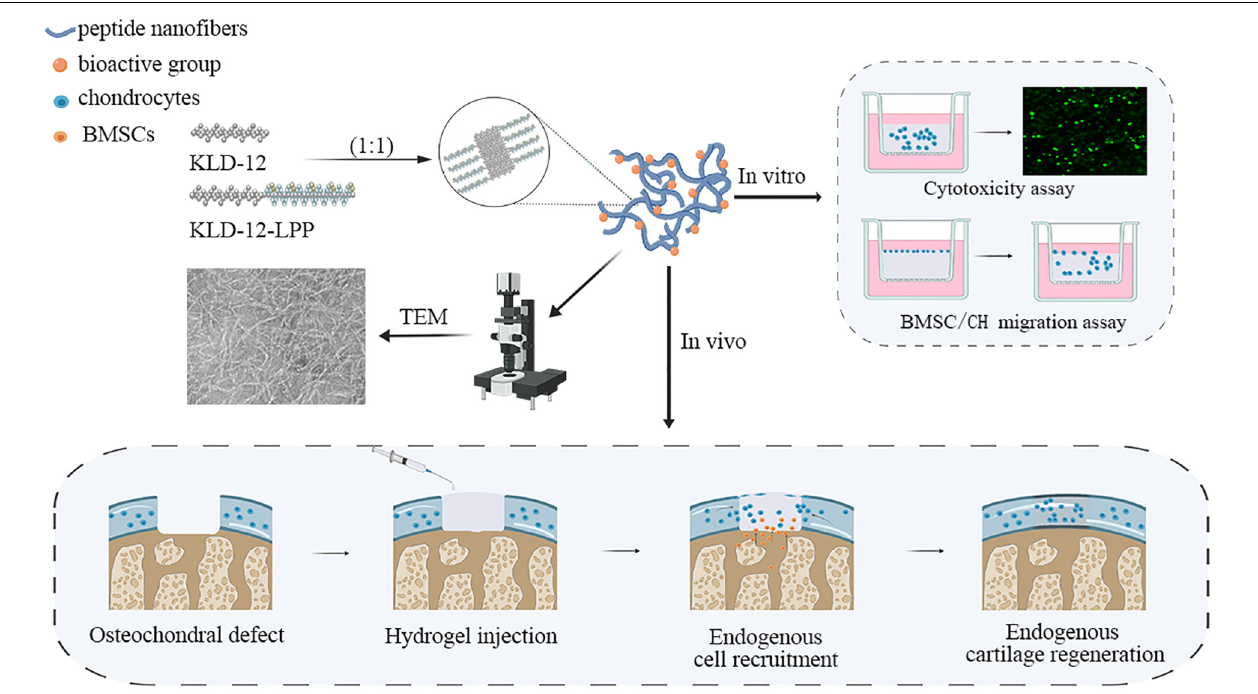
FIGURE 1 | Schematic illustration of the overall research design. TEM, Transmission electron microscopy; BMSC, Bone marrow mesenchymal stem cells; CH,